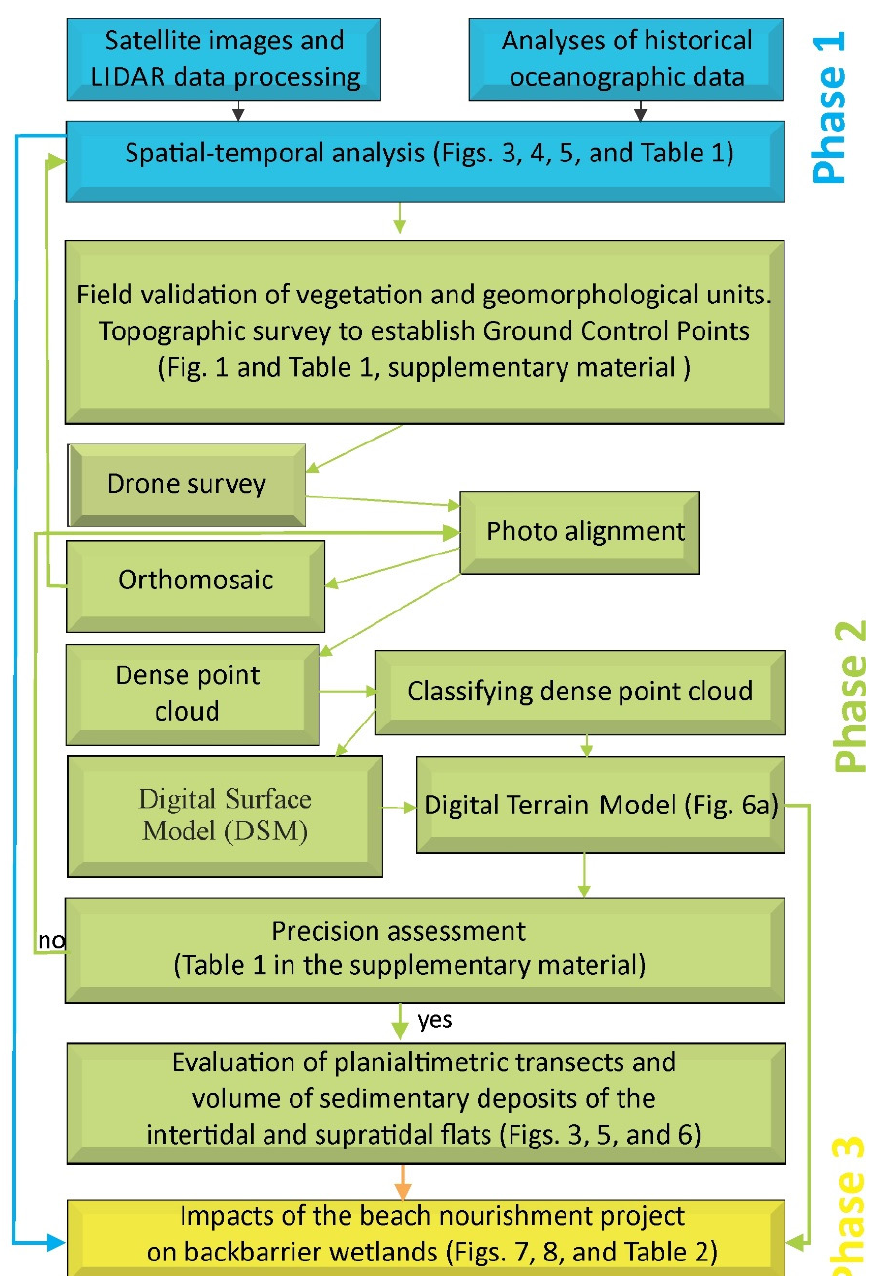
Figure 2. Methodology flow chart.